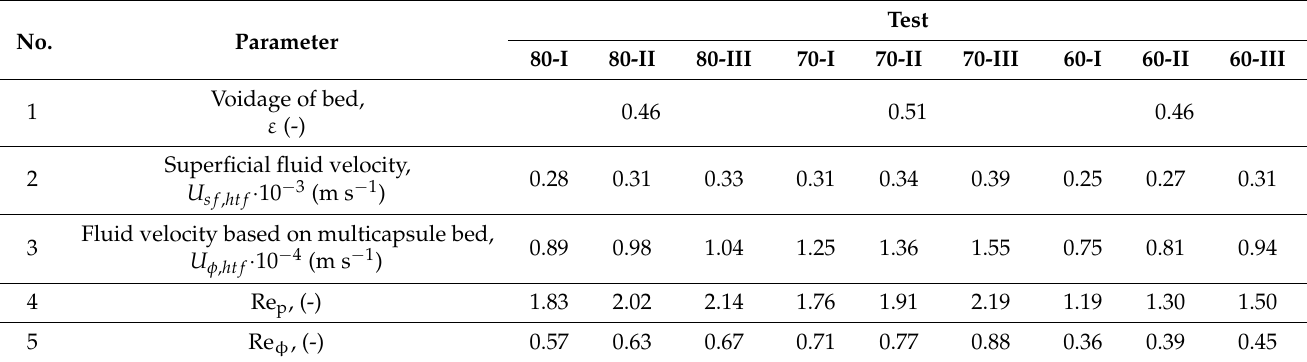
Table 3. Basic operational parameters of the testing